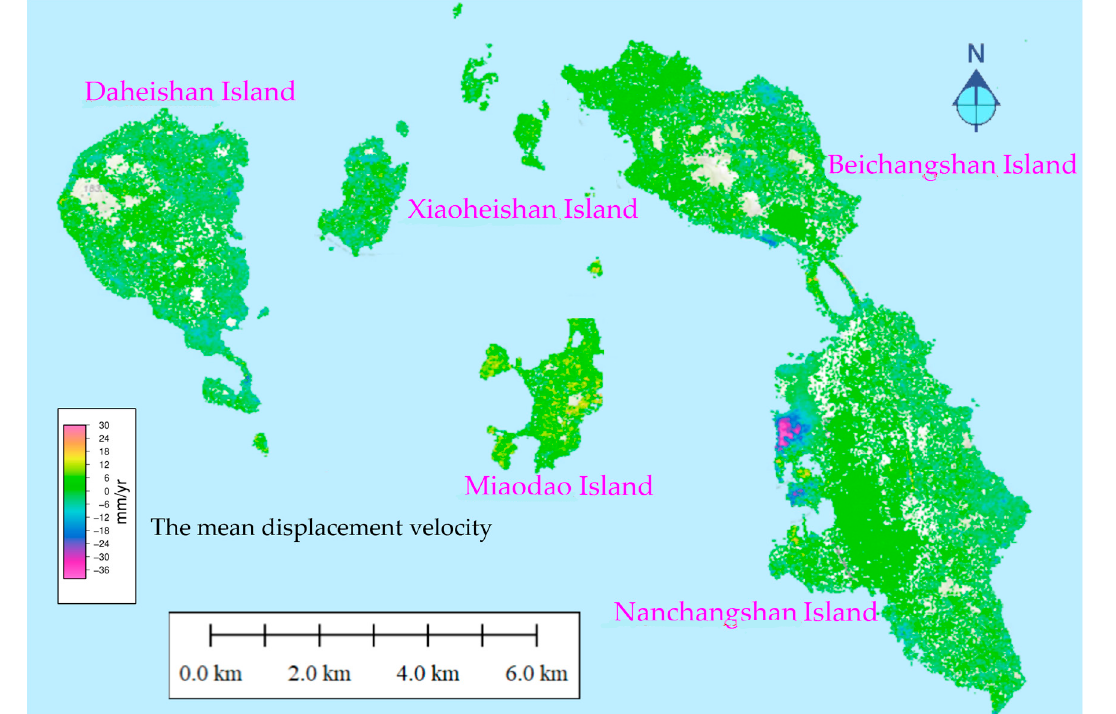
Figure 5. The mean displacement velocity map obtained based on Sentinel-1 data.